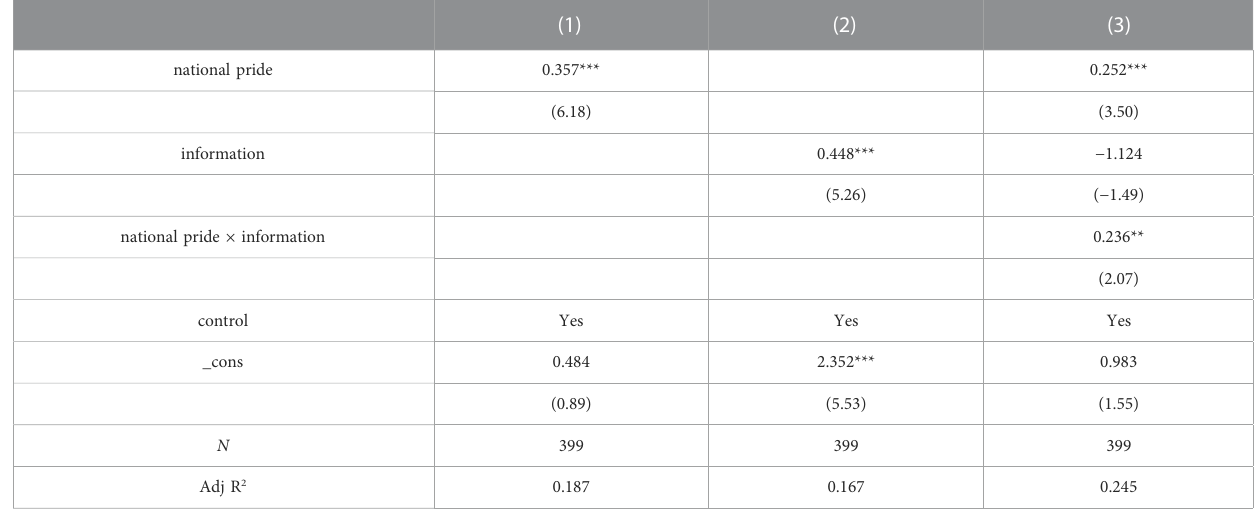
TABLE 4 The relationship between national pride, information, and